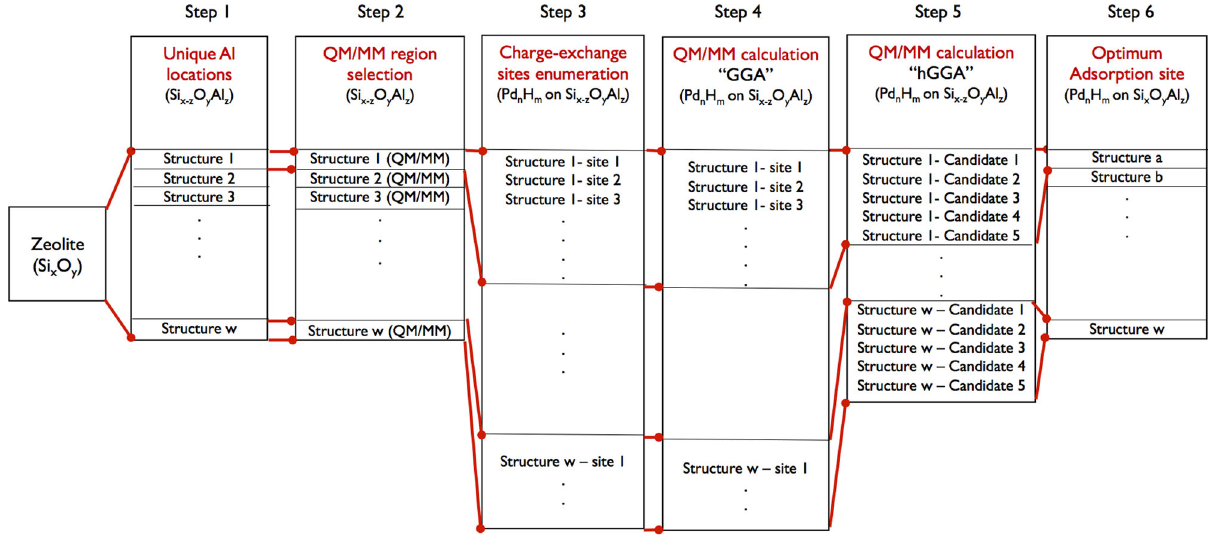
Fig. 1 Work fl ow of the high-throughput approach used in this work. Pd n H m ( n = 0, 1 or 2 and m = 0, 1, or 2) is used as an illustration. Starting with the zeolite material, structures are generated by identifying the unique Al position(s) in step 1 (generating structures from 1 to w), followed by identifying atoms in the QM and MM region for each structure in step 2. In step 3, possible charge-exchange sites are enumerated and then further evaluated in step 4 using QM/MM calculations at the GGA level. The 5 most favorable exchange sites from step 4 for each unique Al position are further evaluated at the higher hGGA level of theory in step 5. Finally, all structures from step 5 are ordered based on their energy stability, yielding the most energetically favorable sites for the exchange in the zeolite in step 6.